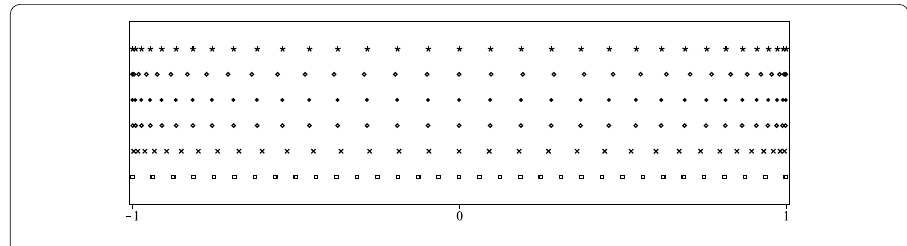
Figure 3 Graphs of sets of 33 nodes; ( ∗ ) ˘ T , ( (cid:3) ) ¯ U , ( • ) ˆ T , ( ◦ ) T , ( × ) U , ( (cid:2) ) E from top to bottom.